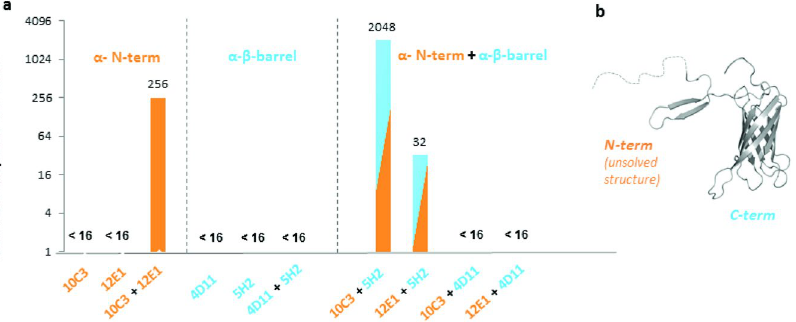
Figure 4. Functionality of anti-NHBA mAbs assessed by the Serum Bactericidal Activity Assay. Rabbit serum bactericidal assay (rSBA) titers obtained with combinations of mAbs targeting the N-terminal (orange) or beta-barrel (blue) of NHBA. ( a ) Three-dimensional structure of the C-term domain of NHBA 21 . Structural data are not yet available for the N-terminal domain. ( b ) Threshold for positive titer was defined as > 16, antibody couples are considered cooperative if the titer obtained with mAbs combination is at least fourfold higher than titer obtained with single